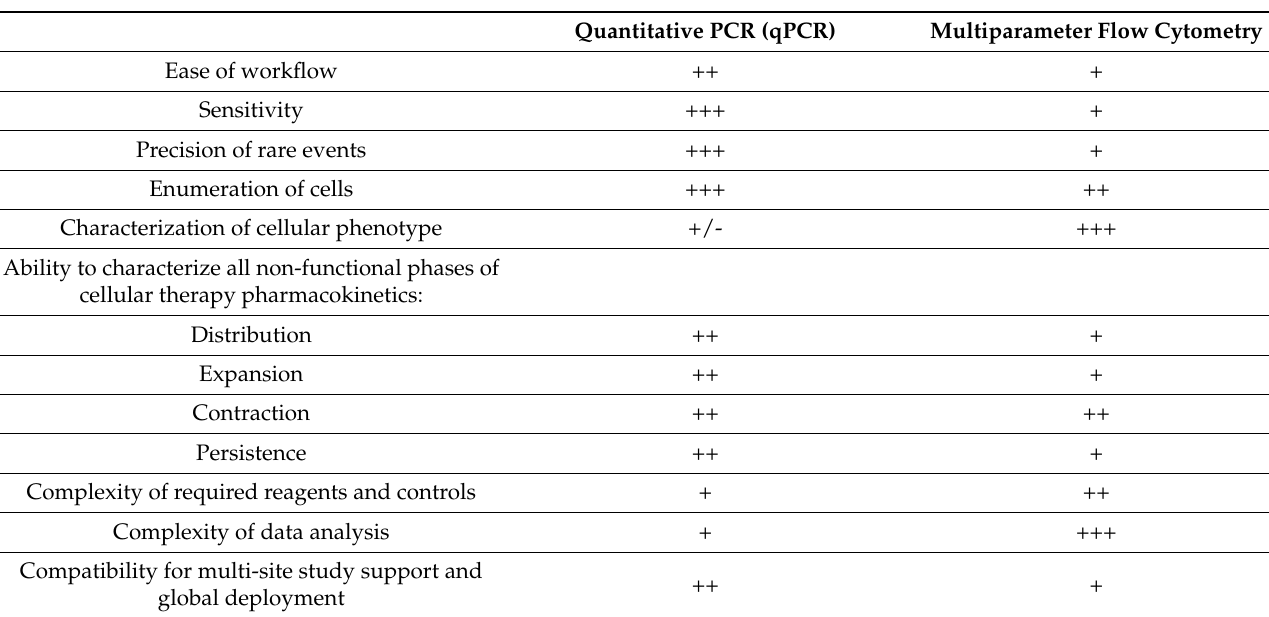
Table 1. Comparison of qPCR and Flow Cytometry Platforms for Cellular